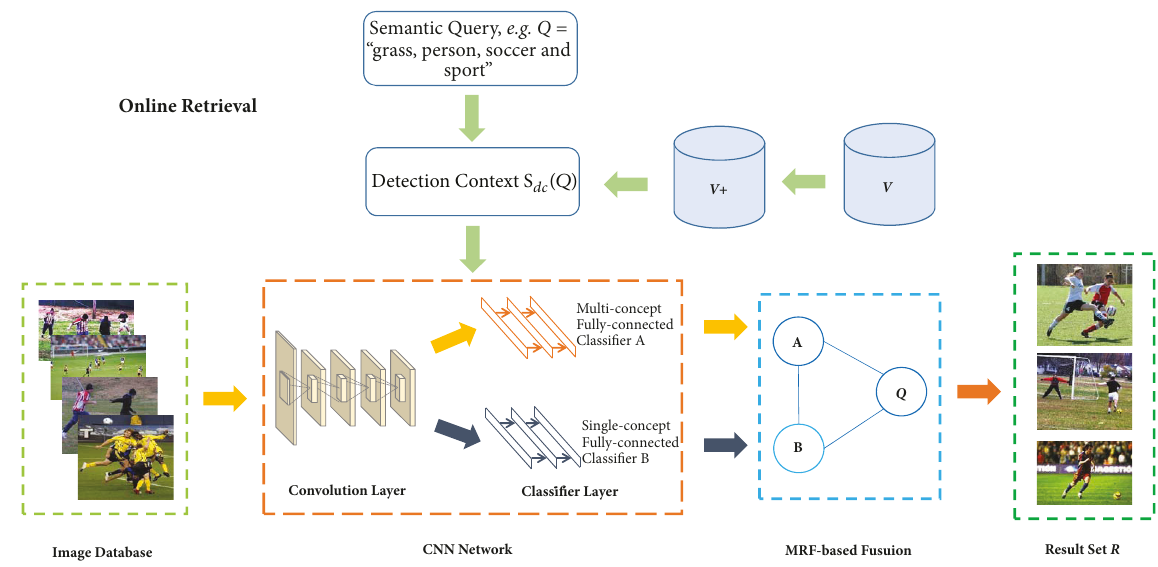
Figure 1: The proposed CMMR